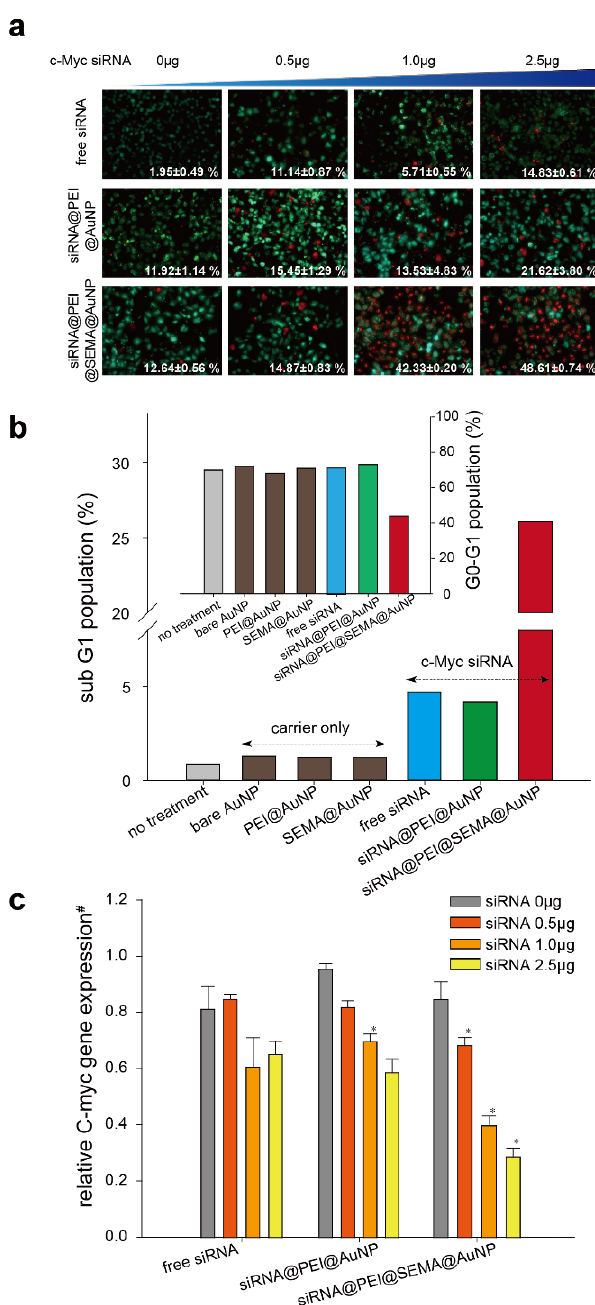
Figure 5. Anti-cancer e ff ects of AuNPs. ( a ) LIVE / DEAD assay against A549 cells. Cells were stained by calcein AM (green) and ethidium homodimer-1 (red) for live and dead cells, respectively. Populations of dead cells out of total cells (100 cells) were image-analyzed to calculate populations of dead cells. At least three images were analyzed for each group and labeled in each image. ( b ) Cell population at sub-G1 phase was determined by flow cytometry to measure the apoptotic e ff ect of siRNA@PEI@SEMA@AuNP. Inserted graph describes percentage of cells at G0-G1 phase. Histograms of flow cytometric analysis are shown in Figure S3. ( c ) C-myc gene expression level was measured by quantitative real-time PCR. #Normalized to GAPDH expression levels of free siRNA. * indicates a statistical significance in respect to free siRNA ( p <0.05).